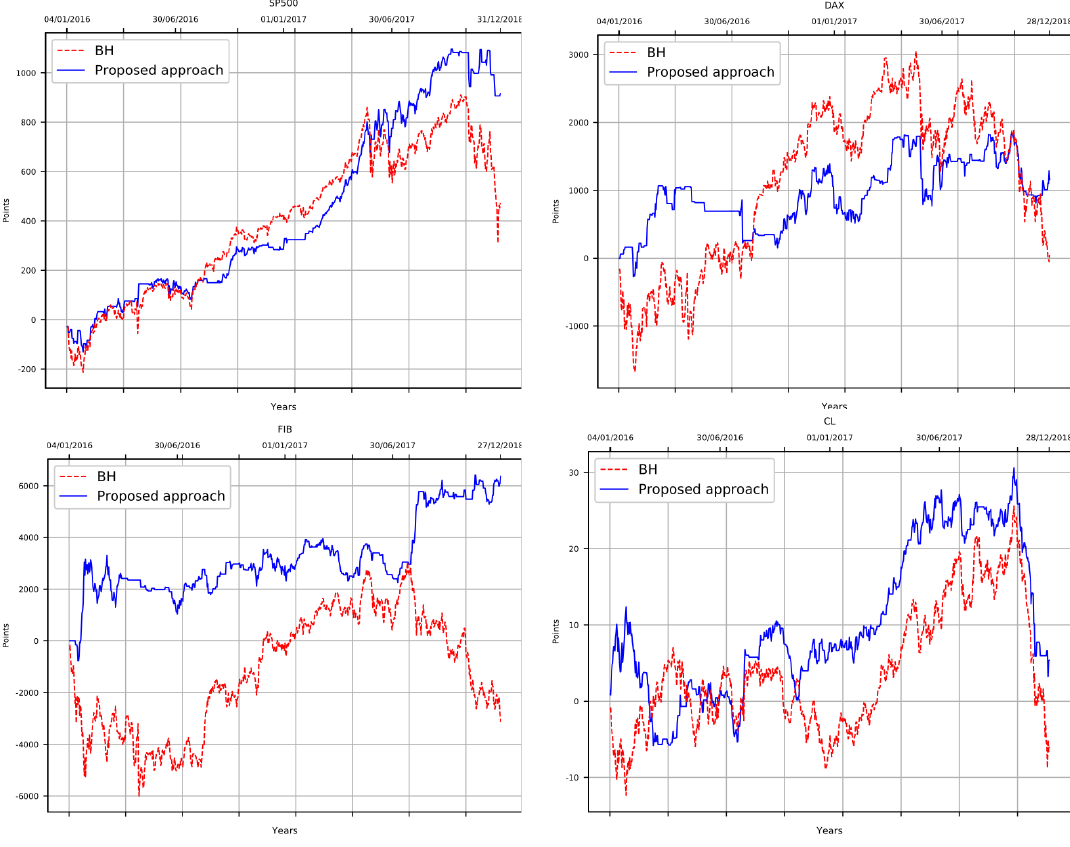
Figure 2. Equity